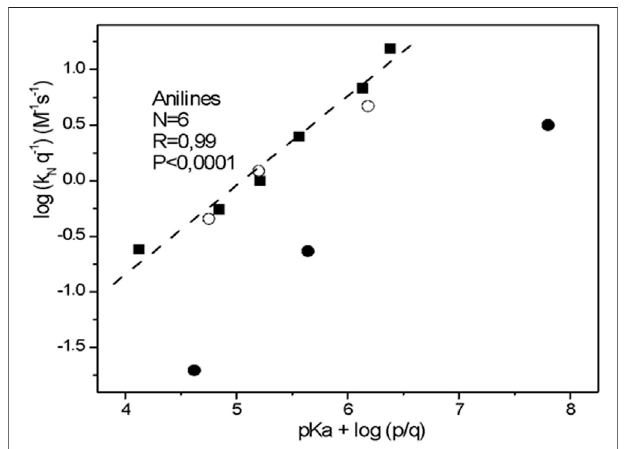
FIGURE 2 | Brønsted -type plot (statistically corrected) obtained for the reactions of 2-choro-5-nitro pyrimidine with aniline series in aqueous solution, at 25.0 ° C and ionic strength of 0.2 M in KCl (full square). The empty circles correspond to: N , O -dimethyl hydroxylamine, N , N -dimethyl hydroxylamine and N-methyl hydroxylamine compounds and full circles correspond to: methoxylamine, hydroxylamine and hydrazine compounds, respectively (see Figure 1